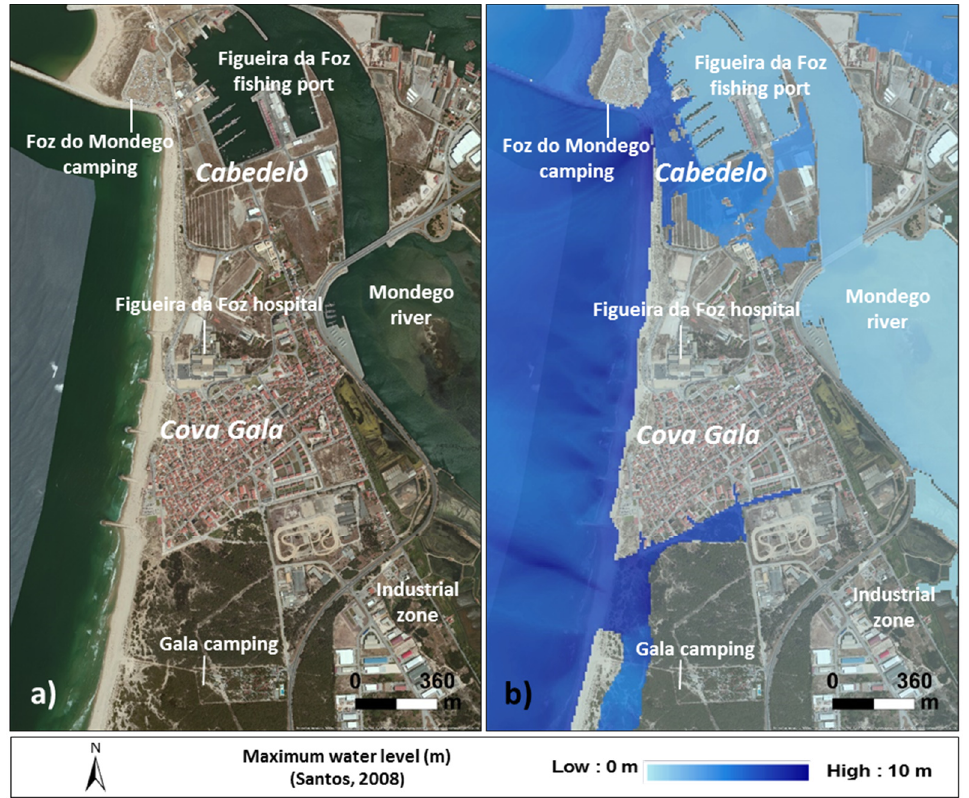
Figure 2. Cabedelo study area: ( a ) Satellite imagery from study area; ( b ) Tsunami inundation from numerical model results for Cabedelo